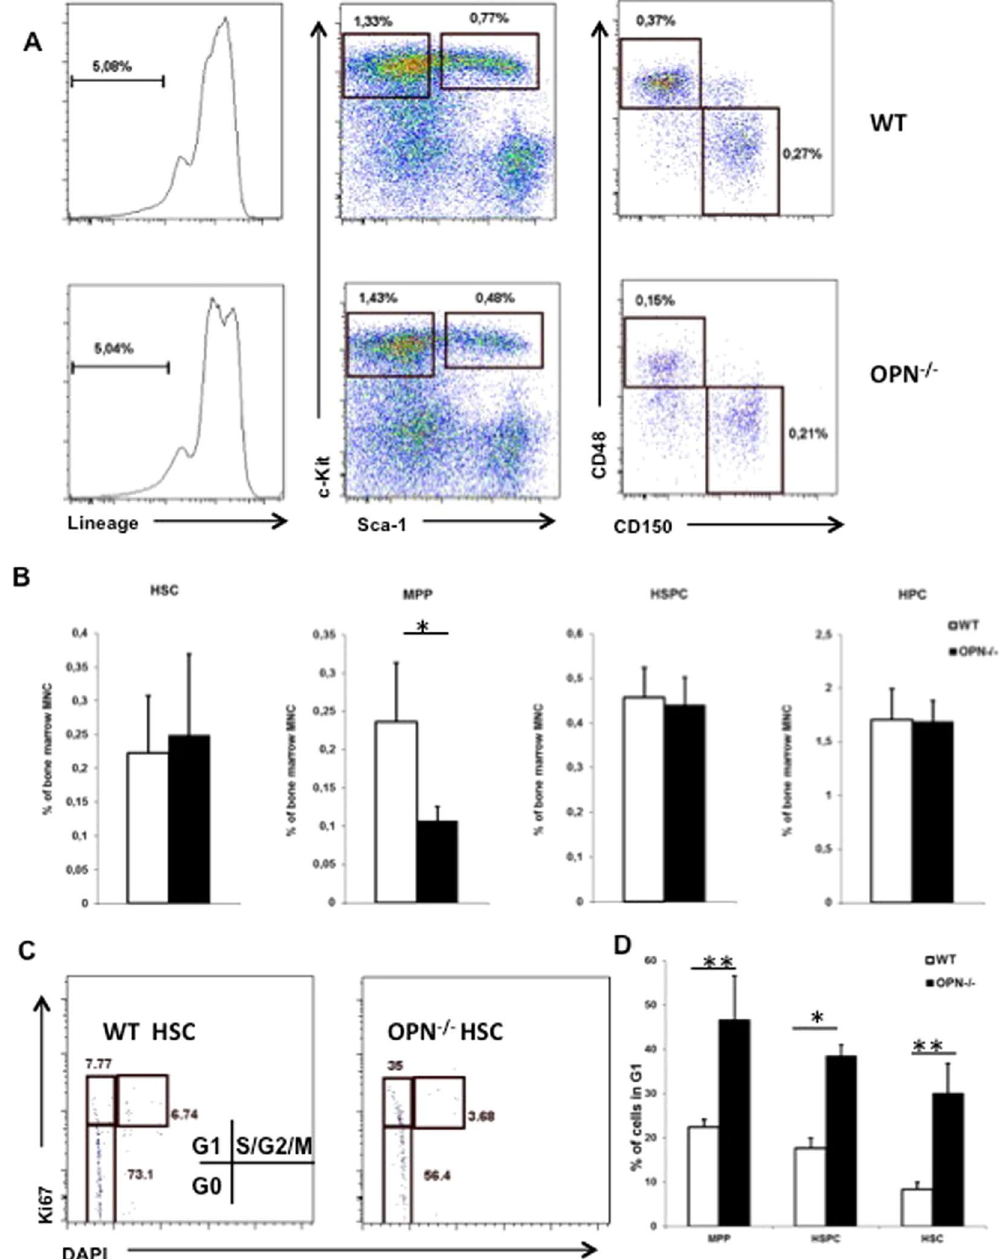
Figure 2. OPN alters the composition of the primitive HSC compartment. ( A ) Representative plots from 22-month-old WT and OPN − / − bone marrow cells. ( B ) Cumulative data of HSPC subpopulations calculated as percentage of total bone marrow mononuclear cells. Values are the mean ± SD; n = 7; * P ≤ 0.05. ( C ) Representative plots of cell cycle analyses by Ki67 and DAPI gated on HSC population. ( D ) Cumulative analyses of the proportion of stem and progenitor cells in G1 phase of the cell cycle in WT and OPN − / − mice. Values are the mean ± SD; n = 3; * P ≤ 0.05, ** P ≤